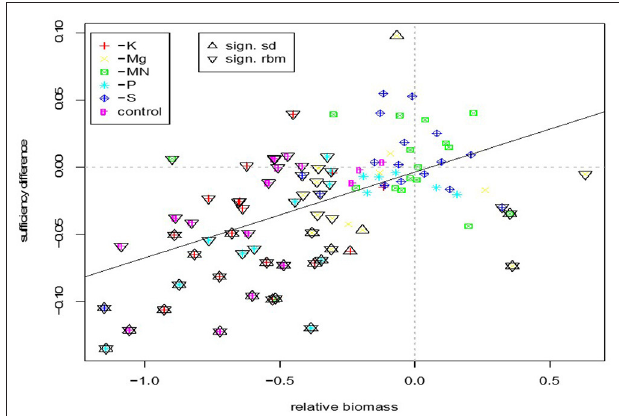
FIGURE 3 | Relationship between sufficiency difference and relative biomass for the different nutrients in specific soils. Significant values are marked by up and down facing triangles for sufficiency difference and relative biomass, respectively. Stars indicate simultaneous significance for relative biomass and sufficiency